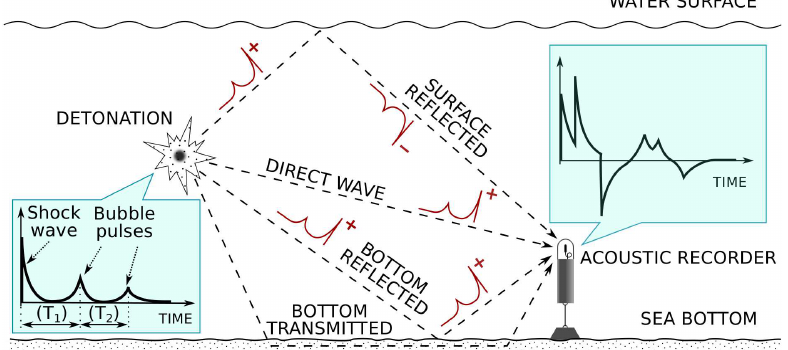
Figure 1. Main wave reflections produced by an UNDEX event received by a passive acoustic recorder moored at the bottom of the sea under constant speed of sound